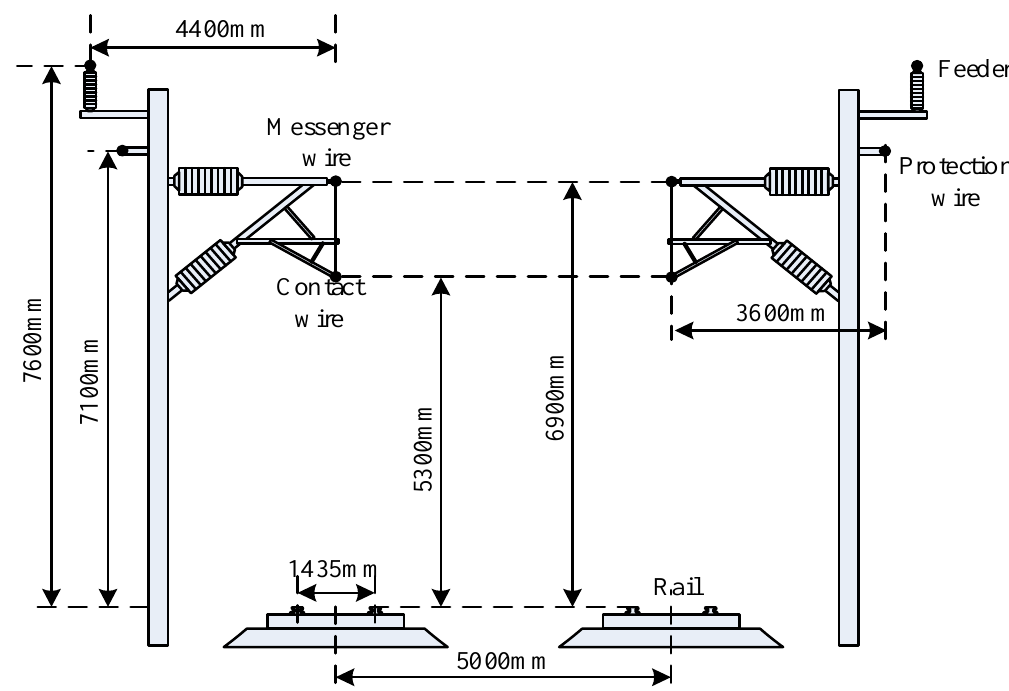
Figure 12. Multi-conductor transmission line system of the traction network.